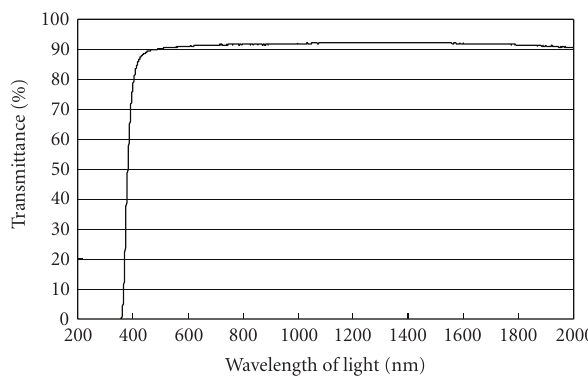
Figure 2: Light transmittance data of the colored glass filter.